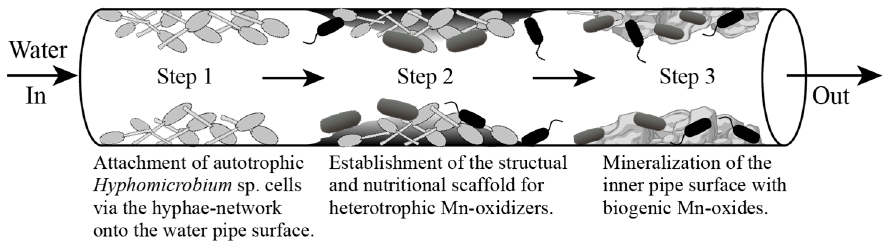
Figure 3. Schematic image of the proposed Mn-deposit formation process in the water pipe.